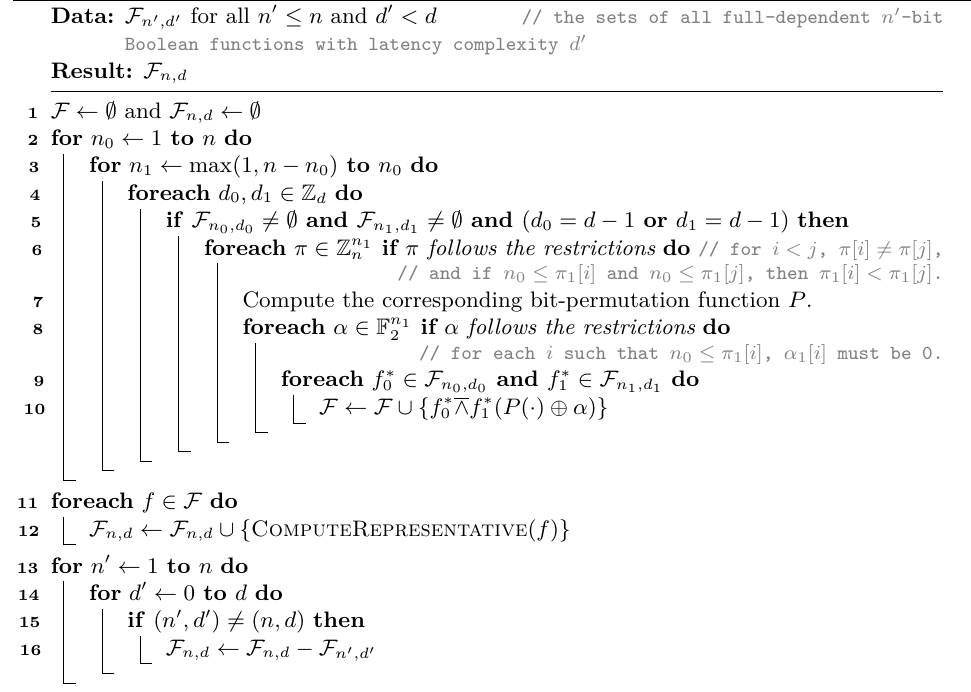
Algorithm 1: Computing F n,d , the set of all full-dependent n -bit Boolean func- tions with latency complexity d up to the extended bit-permutation